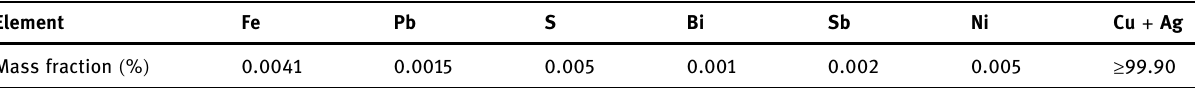
Table 1: Chemical composition of T2 copper Element